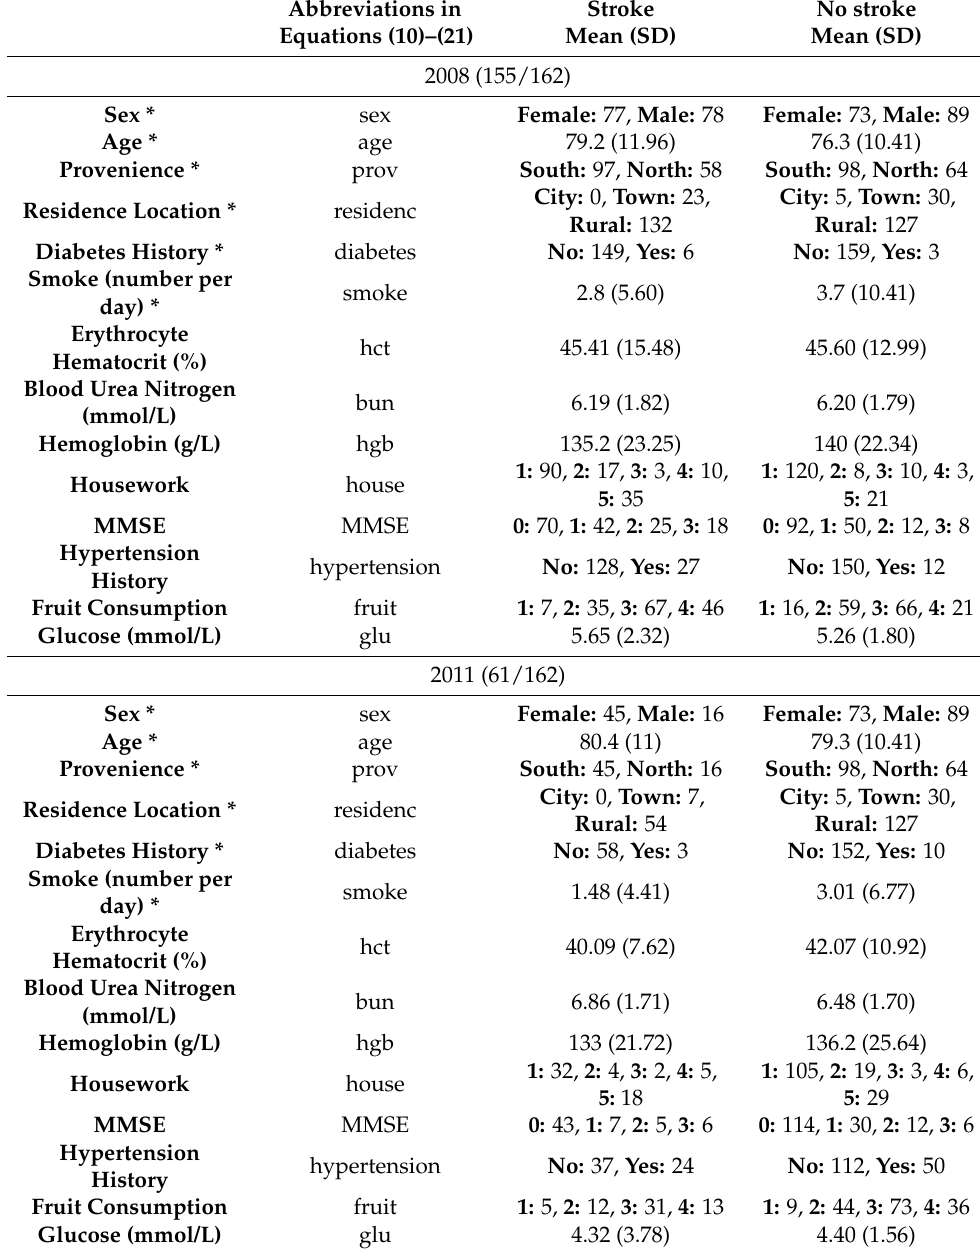
Table 2. Characteristics of remaining risk factors at each measurement for stroke and no-stroke